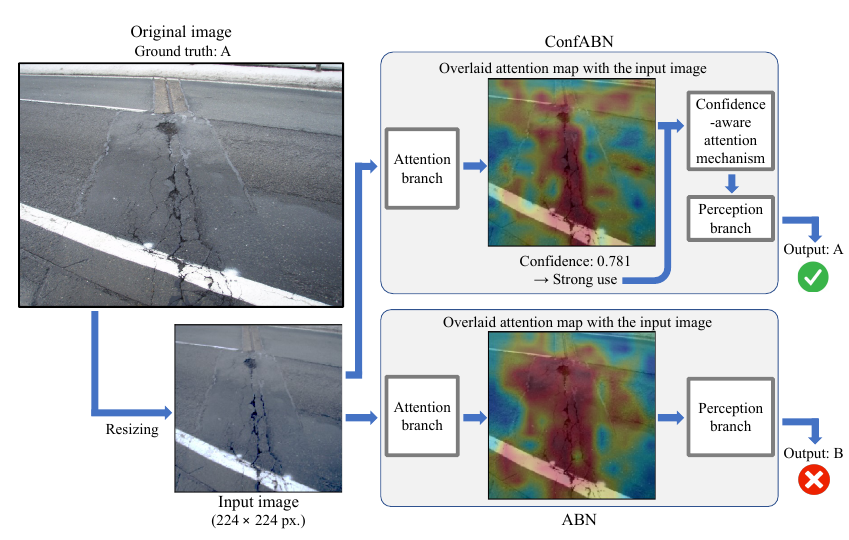
Figure 6. Examples of the estimation results using ConfABN and ABN for the images of a